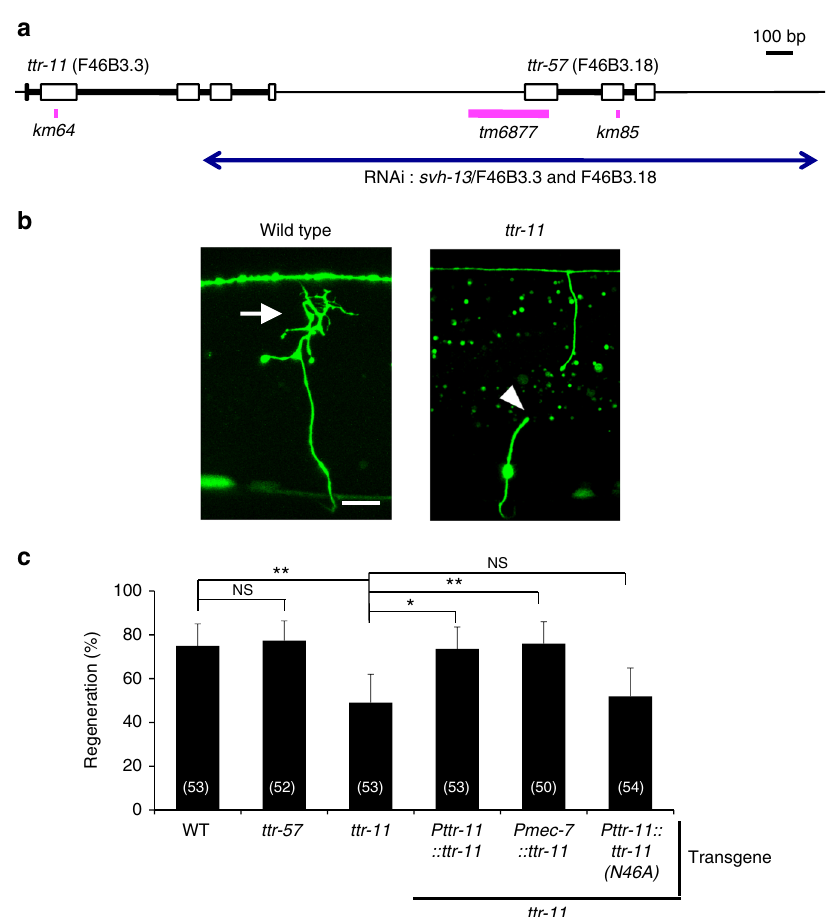
Fig. 1 TTR-11 is required for ef fi cient axon regeneration. a Genomic structures of the ttr-11 and ttr-57 genes and the svh-13 /F46B3.3 and F46B3.18 RNAi clone. The svh-13 RNAi knocks down both the ttr-11 and ttr-57 genes. Boxes and thick lines indicate exons and introns, respectively. The blue line indicates the region targeted by the svh-13 RNAi. The magenta bold lines underneath indicate the extent of the deleted region in each deletion mutant. b Positive and negative regeneration in D-type motor neurons. The positive and negative regeneration examples are from a wild-type animal and a ttr-11 mutant, respectively, 24 h after laser surgery in the L4 stage. In wild-type animals, a severed axon has regenerated a growth cone (arrow) and ~75% of the cut axons are scored as regenerating. In ttr-11 mutants, proximal ends of axons often failed to regenerate (arrowhead). Scale bar = 10 μ m. c Regeneration of D- type motor neurons. Percentages of axons that initiated regeneration 24 h after laser surgery in the L4 stage are shown. The number ( n ) of axons examined are shown. Error bars indicate 95% con fi dence intervals (CIs). * P < 0.05, ** P < 0.01 as determined by Fisher ’ s exact test. NS: not signi fi